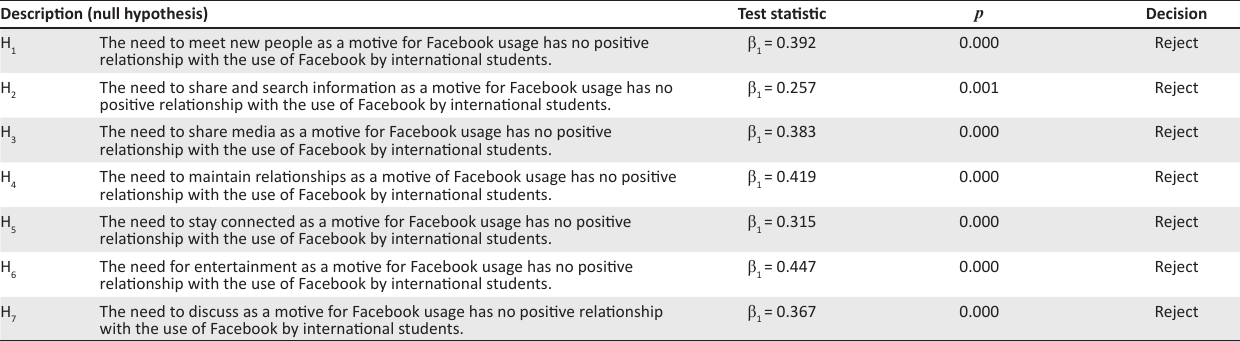
TABLE 6: Summary of the hypotheses results. Description (null hypothesis) Test statistic